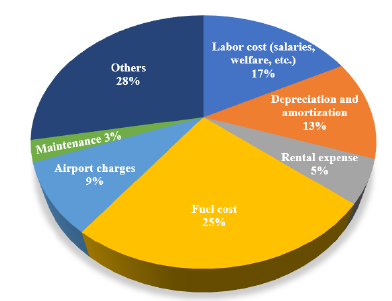
Figure 3. Operating cost breakdown of airlines in Korea